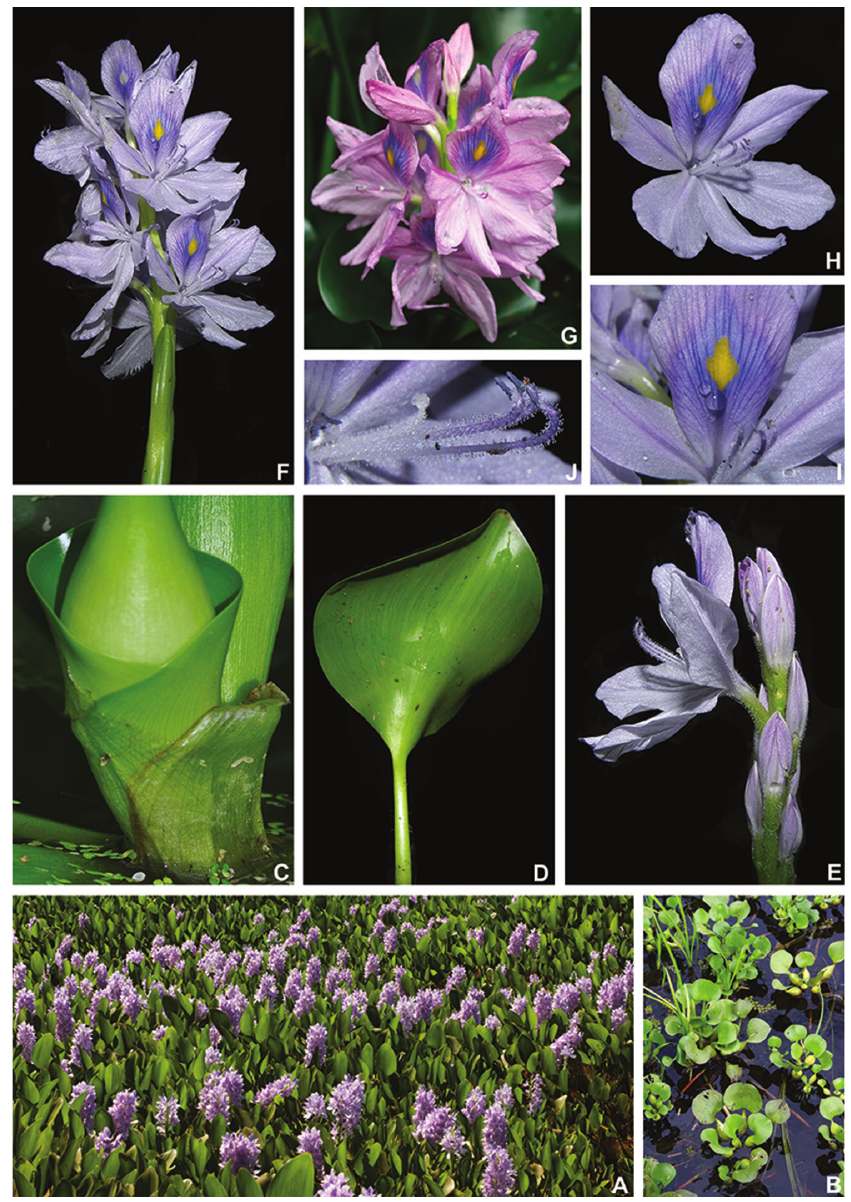
Figure 7. Pontederia subg. Oshunae M.Pell. & C.N.Horn. A–B habit: A dense population of the pink- flowered form B detail of a population, showing the free-floating rosettes, stolons and inflated petioles C–D petiolate leaves: C blade D detail of a young leaf showing its blade enclosing the inflated petiole of the presiding leaf E–G inflorescence: E young inflorescence of a lilac-flowered form F inflorescence of a lilac-flowered form at anthesis G inflorescence of a pink-flowered form at anthesis H–J flowers: H oblique view of a lilac flower I detail of the nectar guide J detail of the androecium and gynoecium showing the glandular hairs. All photos of P. crassipes Mart.; A by C. Willig & L. Nusbaumer B by O. Gaubert C by K. Pritchard & S.A. Harris, D–F, H–I by R. Aguilar and G by M.O.O.